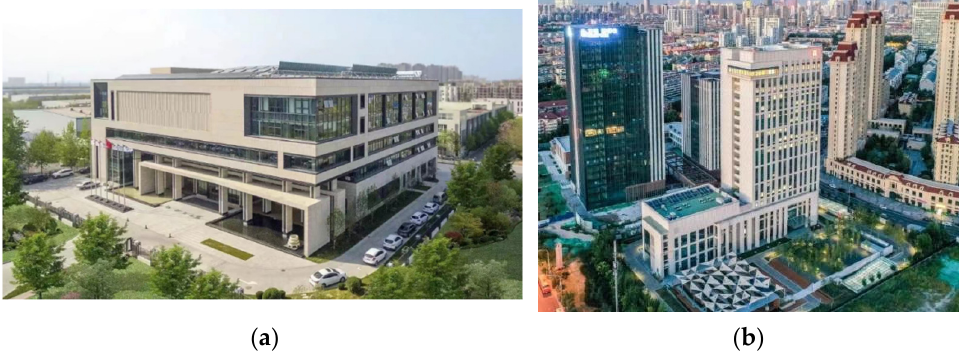
Figure 3. ( a ) Exterior of Case Building A, ( b ) exterior of Case Building B.